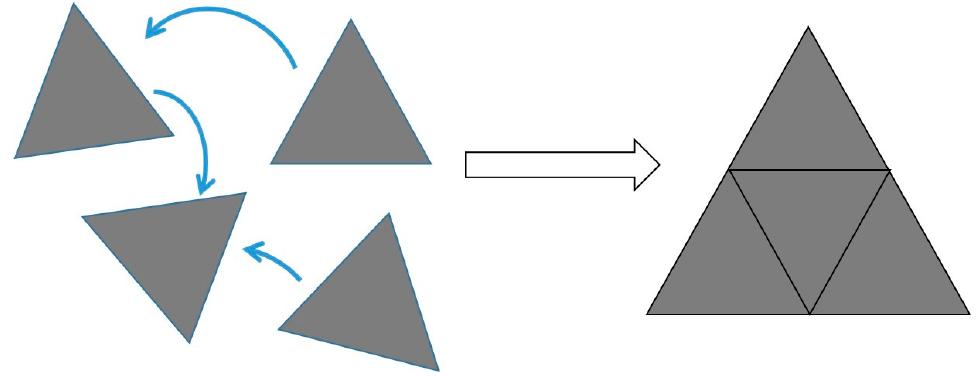
Figure 1. Examples of absorption spectra from spherical NPs (blue line) and flat NPTs (red line). Insets: SEM images from the corresponding structures.